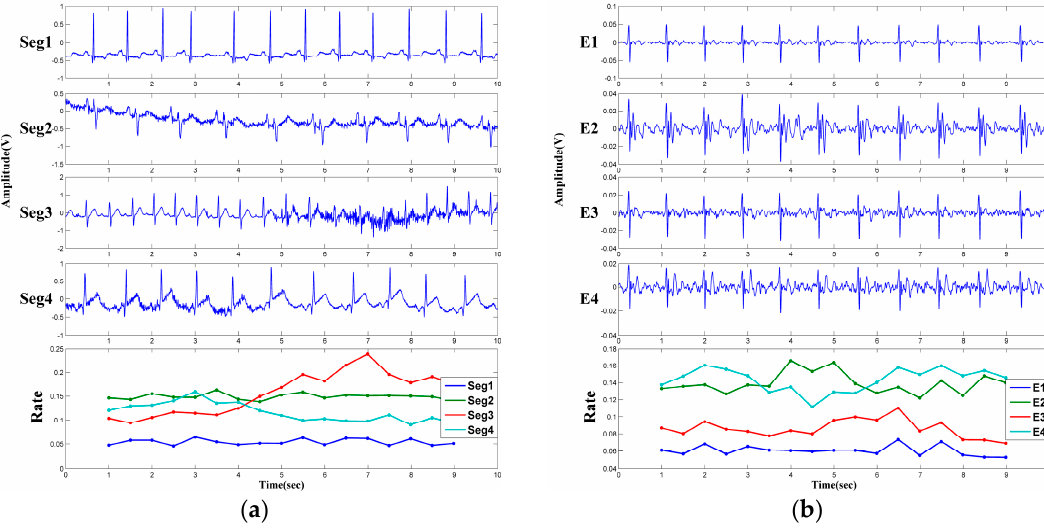
Figure 7. ECG signals and the corresponding 𝑅𝑎𝑡𝑒 values: ( a ) ECG signals obtained from MIT-BIH Database; ( b ) ECG signals measured by the proposed system.